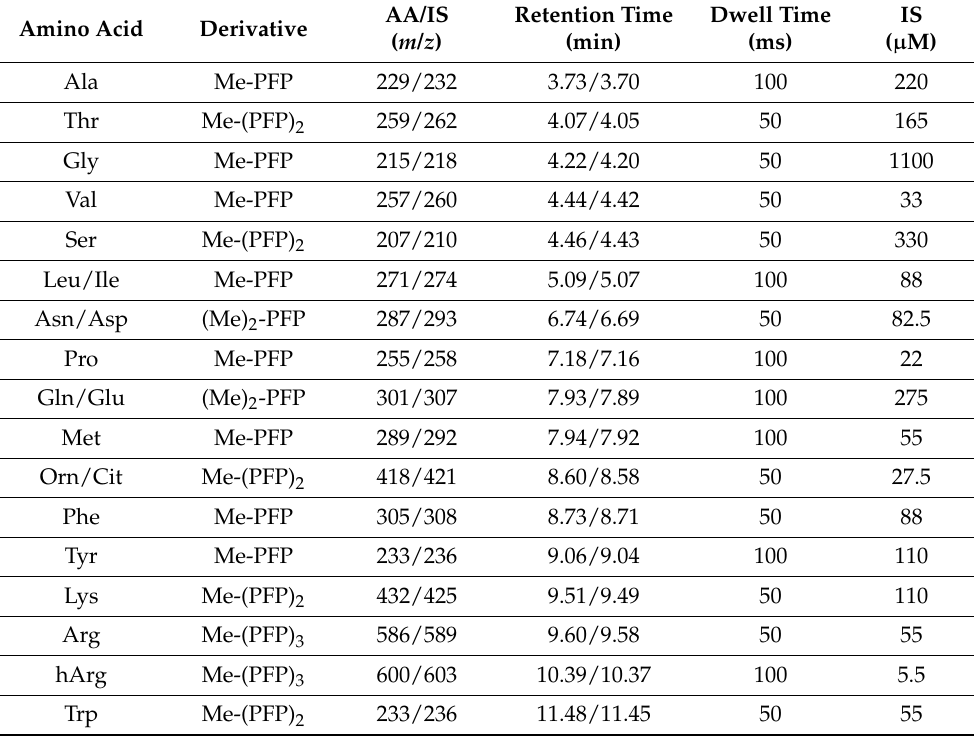
Table 1. Summary of the GC–MS conditions used for the simultaneous quantitative determination of the indicated amino acids (AA) in human urine using their stable-isotope labelled analogs as internal standards